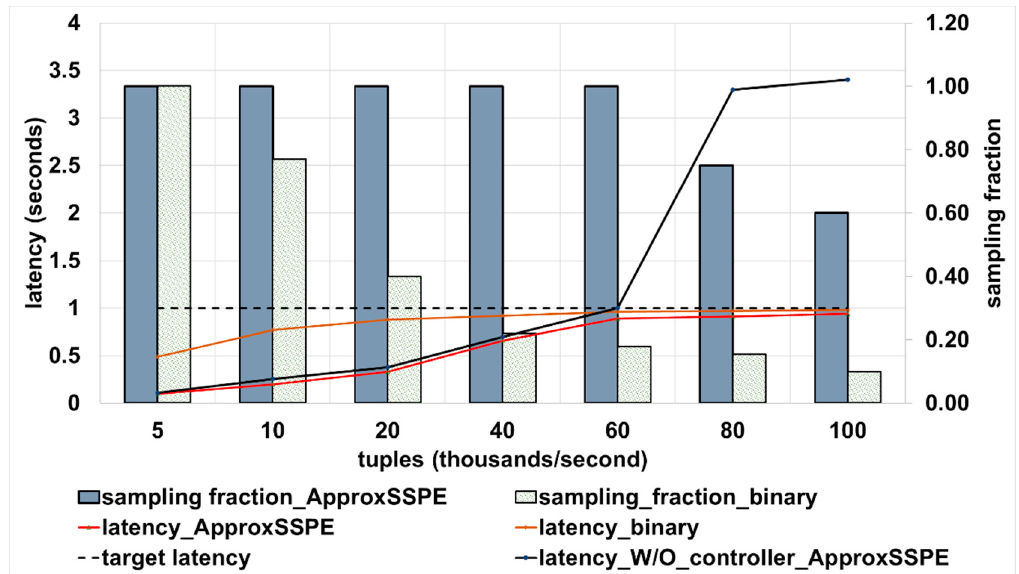
Figure 3. Results of applying latency controller of ApproxSSPS for temporally variable arrival rates. Compared to the binary tree ‐ based baseline [8], and to the case where no controller is applied. A higher sampling fraction is more desirable (i.e., achieves higher accuracy). To maintain system stability and remain within the boundaries of the target latency as more data arrives, where both methods resort to lowering the sampling fraction. However, at a slower pace for ApproxSSPS as opposed to the baseline.